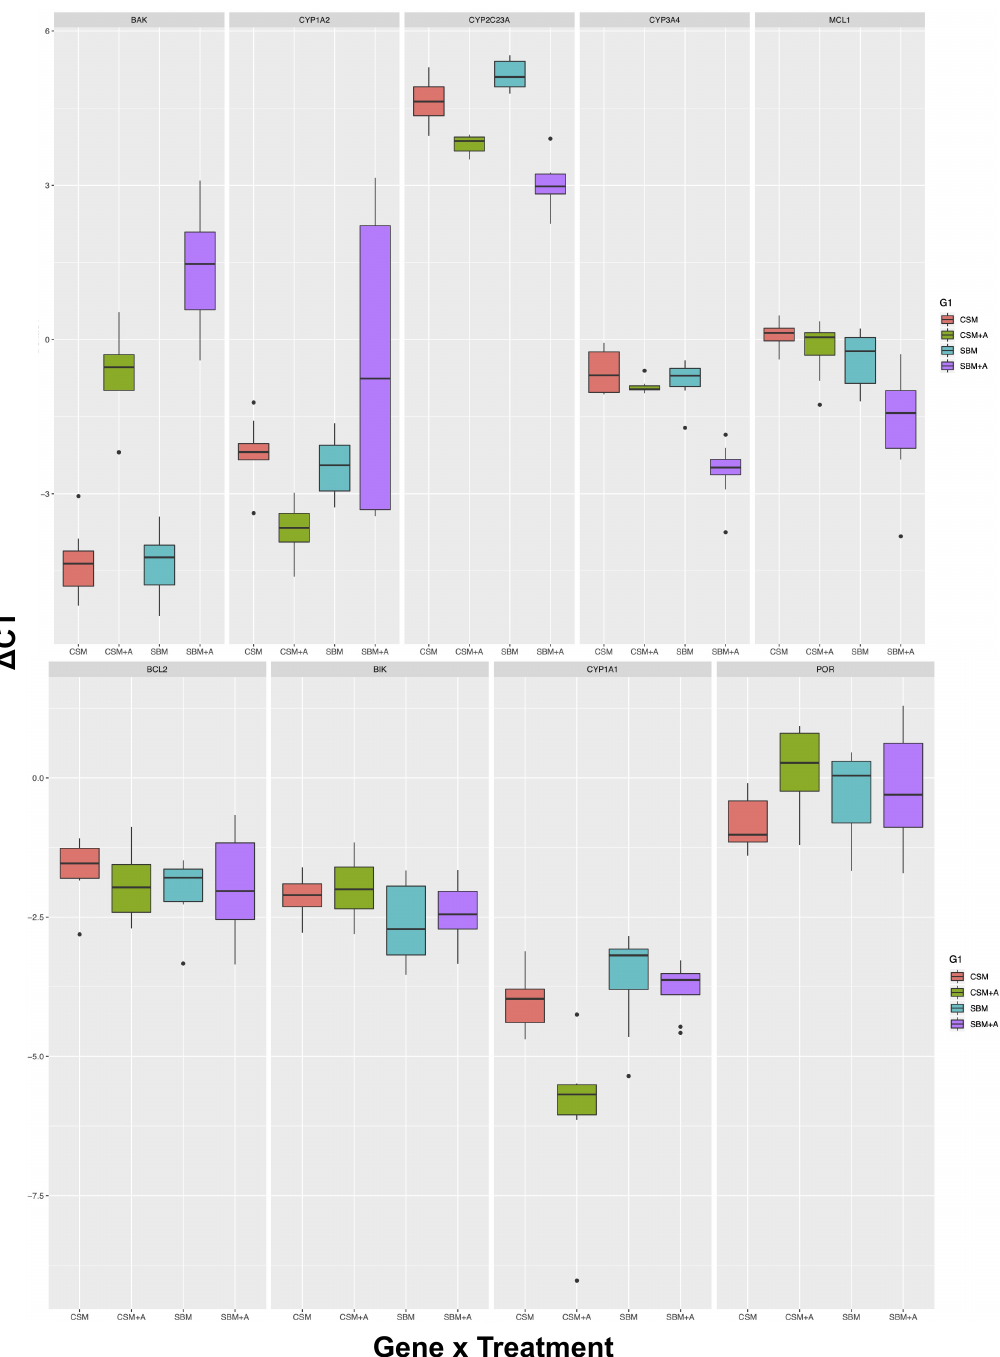
Figure 1. Boxplots showing the di ff erential expression of homeostatic genes in the livers of laying hens raised on SBM, CSM, SBM + YCW, and CSM + YCW diets. The y-axis values are ∆ CTs, and each dietary treatment is represented by di ff erent colors. The gene of interest is named at the top of each panel.